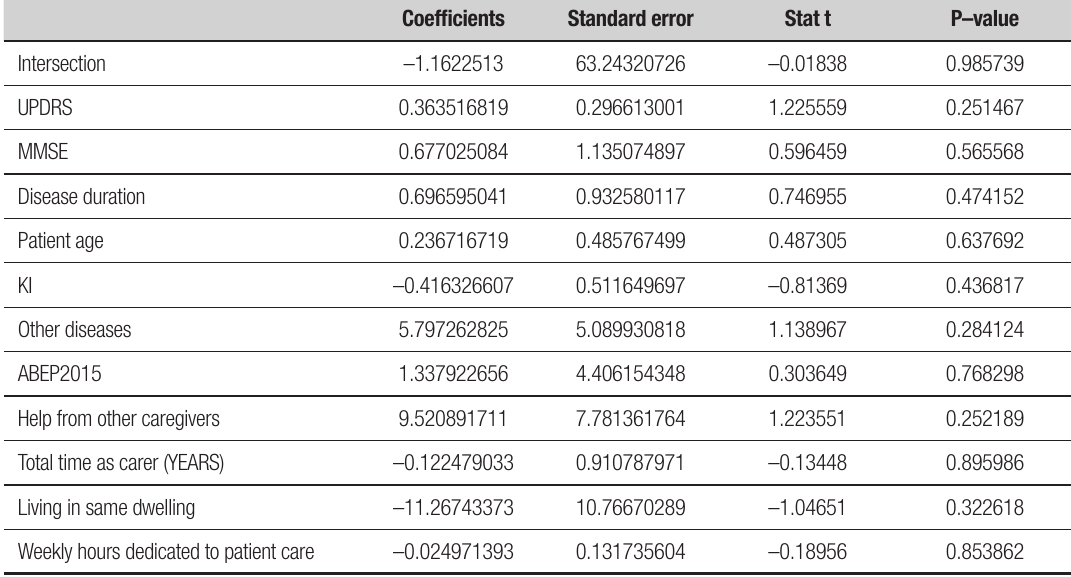
Table 2. Influence of all variables on ZBI scores. Multivariate linear regression analysis